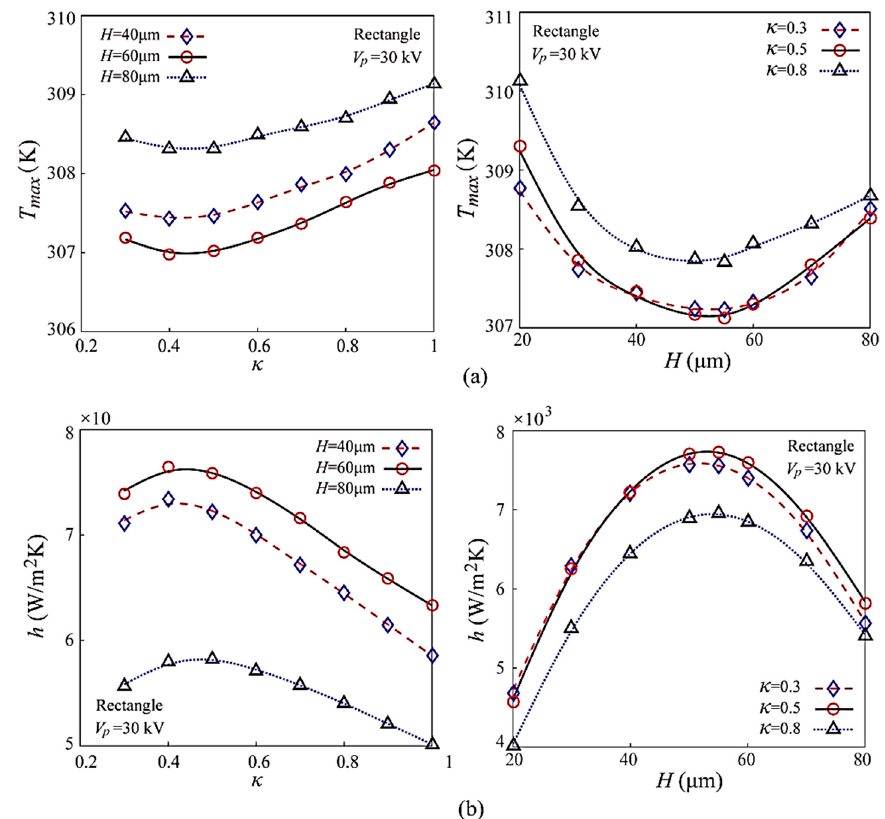
Figure 8. Effect of daughter-to-parent channel width ratio and channel height on the maximum temperature ( a ) and average convective heat transfer coefficient ( b ) of the Y-shaped rectangular microchannel heat sink.